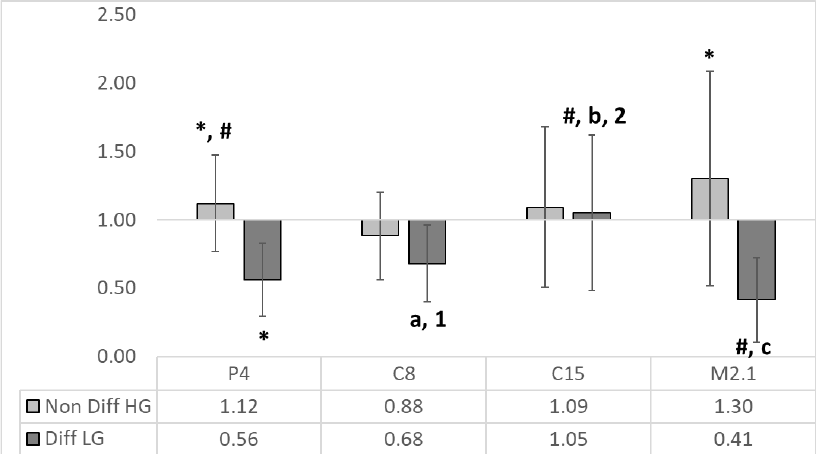
Figure 3. The relative expression of IAP to the MRS HG/LG control ( n = 4, ±SEM). The